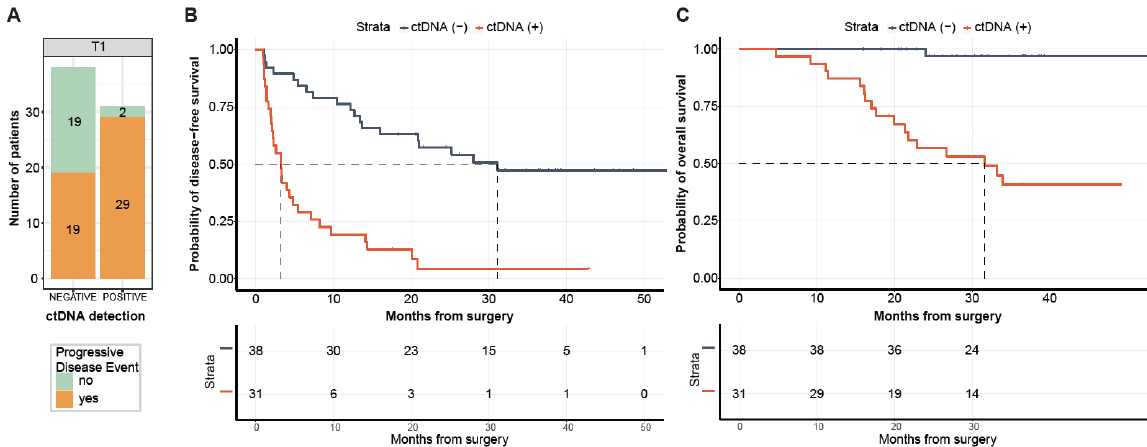
Figure 4. ( A ) ctDNA detection rates at time point T1. ( B , C ) Kaplan–Meier estimates for 69 patients monitored by FoundationOne ® Tracker stratified by ctDNA detection (MRD) at the postsurgical time point (T1). Median lead time = 2.4 months, based on 29 patients with ctDNA (+) at T1 and disease progression. DFS = Disease-free survival, defined as time from metastases resection to the date of the first evidence of progressive disease, as defined by RECIST criteria. OS = overall survival.